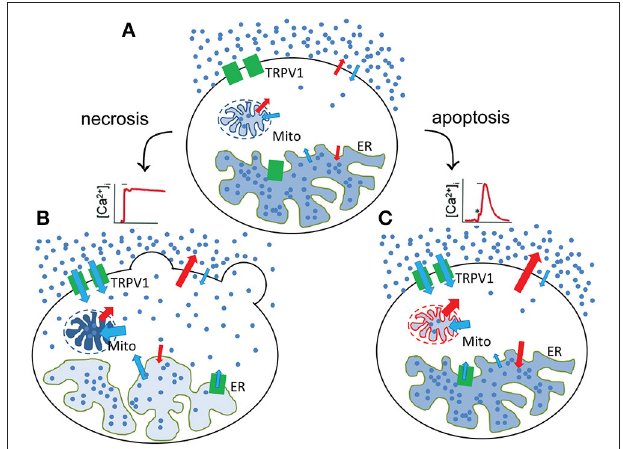
FIGURE 3 | Necrotic and apoptotic processes after TRPV1 stimulation. (A) In the unstimulated state, the resting [Ca 2 + ] i is the result of the low rate of influx and efflux across the plasma, ER- and mitochondria membranes. Red and blue arrows indicates the energy-requiring and energy-independent fluxes, respectively. After stimulation, two types of Ca 2 + response can be observable leading to necrotic (B) and potentially apoptotic processes (C) . (B) During the necrotic processes TRPV1 activation results in a sustained increase in [Ca 2 + ] i . After that, Ca 2 + ions are accumulated in the mitochondria ( Pecze et al., 2016b ) but released from the endoplasmatic reticulum. These processes lead to the fragmentation of these organelles ( Olah et al., 2001). Blebs appears at the plasmamembrane due to the cell volume increase. (C) During the apoptotic processes TRPV1 activation does not result in a sustained increase in [Ca 2 + ] i , but rather to a transient Ca 2 + signal mainly due to the depletion of the ER Ca 2 + stores. In this situation, Ca 2 + extruding systems is still able